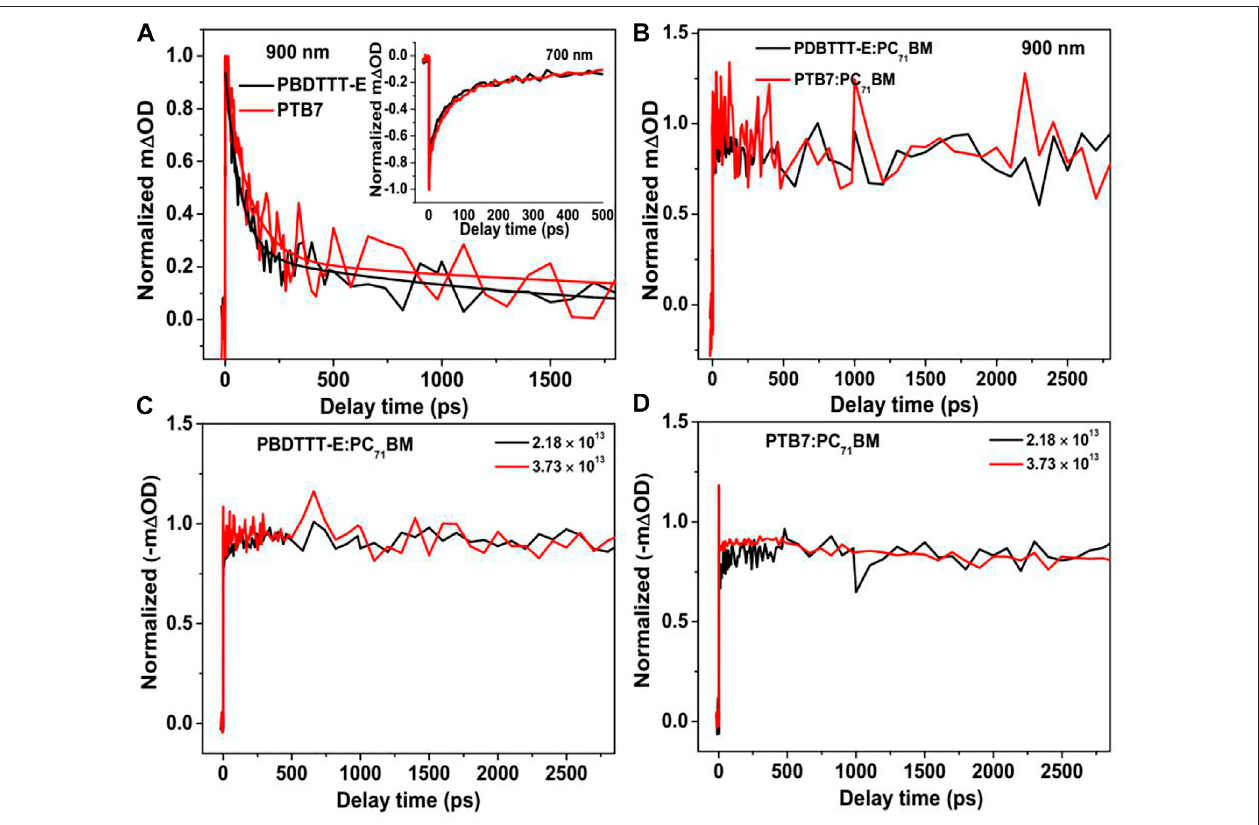
(cid:129) (cid:129) cm − 2 pulse − 1 .